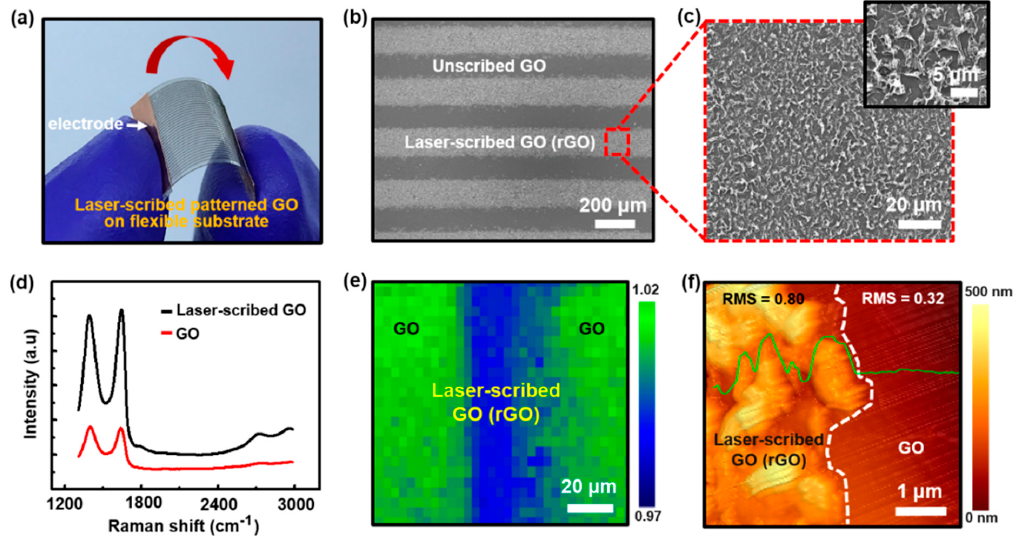
Figure 4. ( a ) Digital image of laser-scribed rGO patterned arrays connected to copper electrodes on